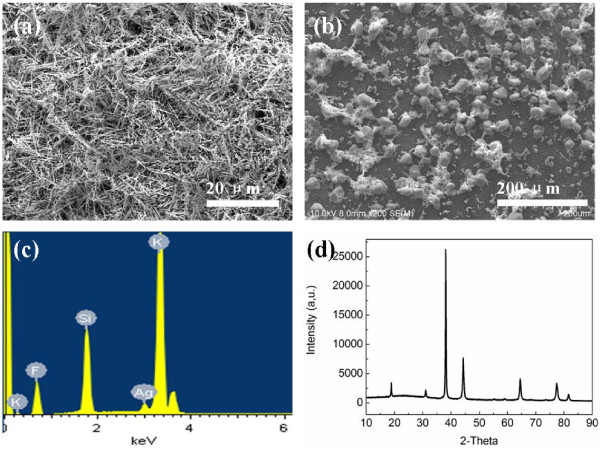
Surface morphology. The silicon sample etched in the solution containing 4.6 M HF, 0.02 M AgNO3, and 0.05 M KMnO4 for 45 min (a) before cleaning by deionized water and (b) after cleaning by deionized water. (c) EDX spectrum and (d) XRD spectra corresponding to (b), respectively.